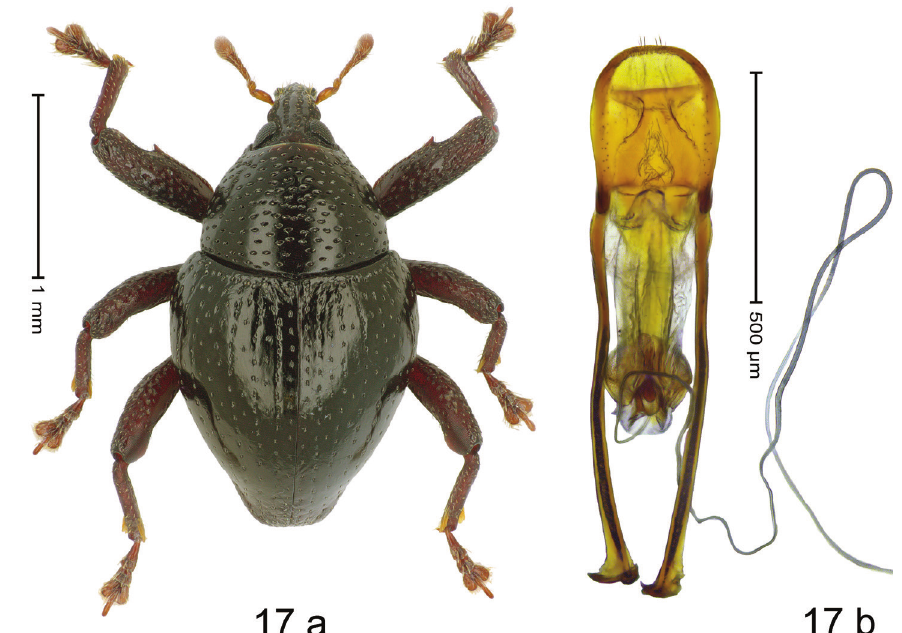
Figure 17. Trigonopterus pompangeensis sp. nov., holotype a habitus b